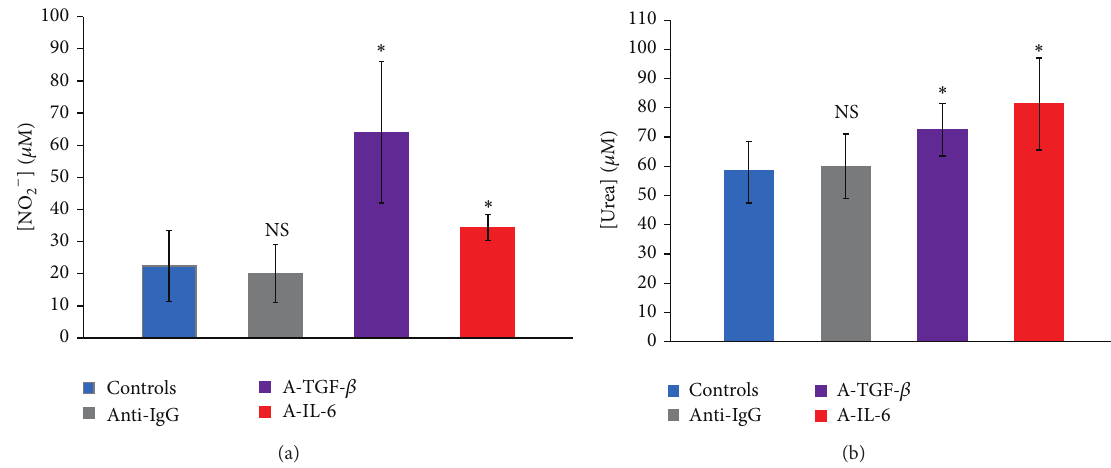
Figure 5: Effect of IL-6 and TGF- 𝛽 neutralization on NO (a) and urea (b) production by patients’ PBMC cultures ( 𝑛 = 35 ) in presence of patients’ plasma at 20% (controls: cultures without antibodies, A-IL-6: anti-IL-6, A-TGF-beta: anti-TGF- 𝛽 , anti-IgG: isotype control IgG, and ∗ : 𝑃 < 0.05 versus control cultures).